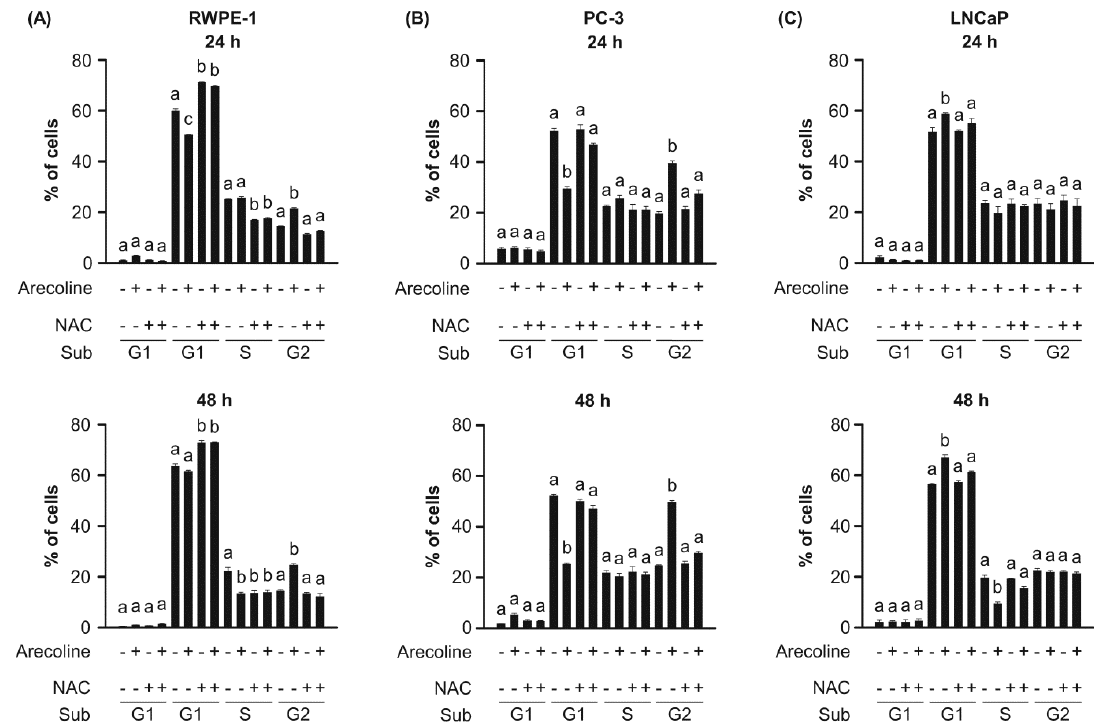
Figure 2. Arecoline-induced growth arrest at different phases of the cell cycle in normal RWPE-1 ( A ), cancerous PC-3 ( B ), and LNCaP ( C ) prostate cells, as examined by flow cytometry after 24 and 48 h of treatment. The induction of growth arrest was affected by N-acetylcysteine (NAC) pretreatment. Cells were pretreated with 1.5 mM NAC for 1 h and then exposed to 0.4 mM arecoline for 24 and 48 h. Data are expressed as the mean ± SEM of triplicate experiments. Groups with different letters were significant ( p < 0.05) in a given phase. In some groups, the standard error bars are too small to be seen. The symbols of “+” and “–“ were presented with or without addition of either arecoline or NAC, respectively.